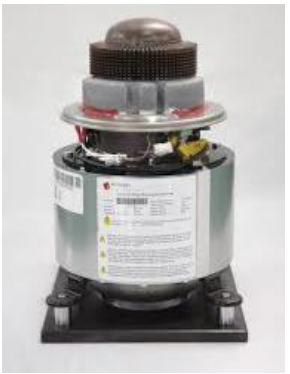
Fig. 5. Stirling engine Whispergen PPS16, power 0.75 kWe [28]